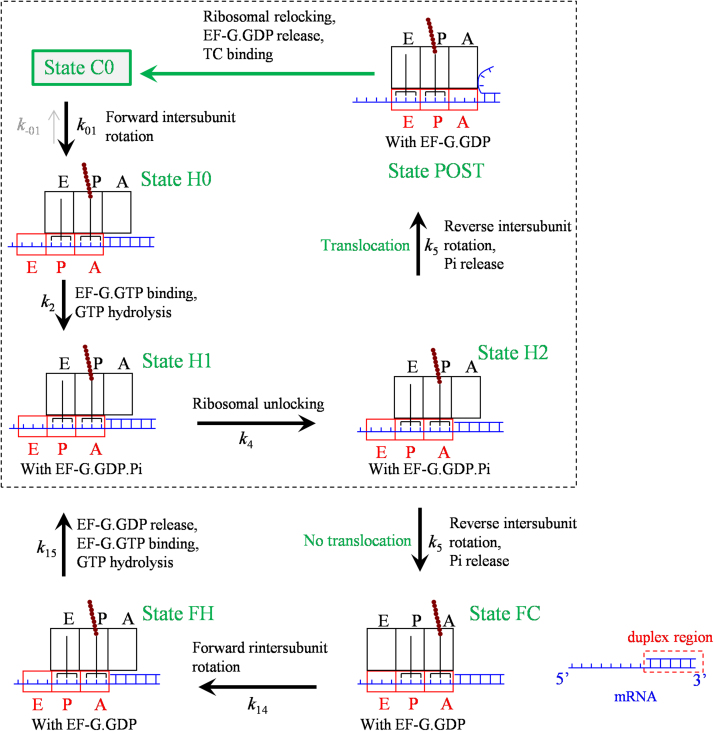
Schematic representation of the elongation pathway for ribosome translation through the mRNA duplex at non-slippery sites (see text for detailed description). Note that the transitions inside the box correspond to the transitions in Fig. 1.